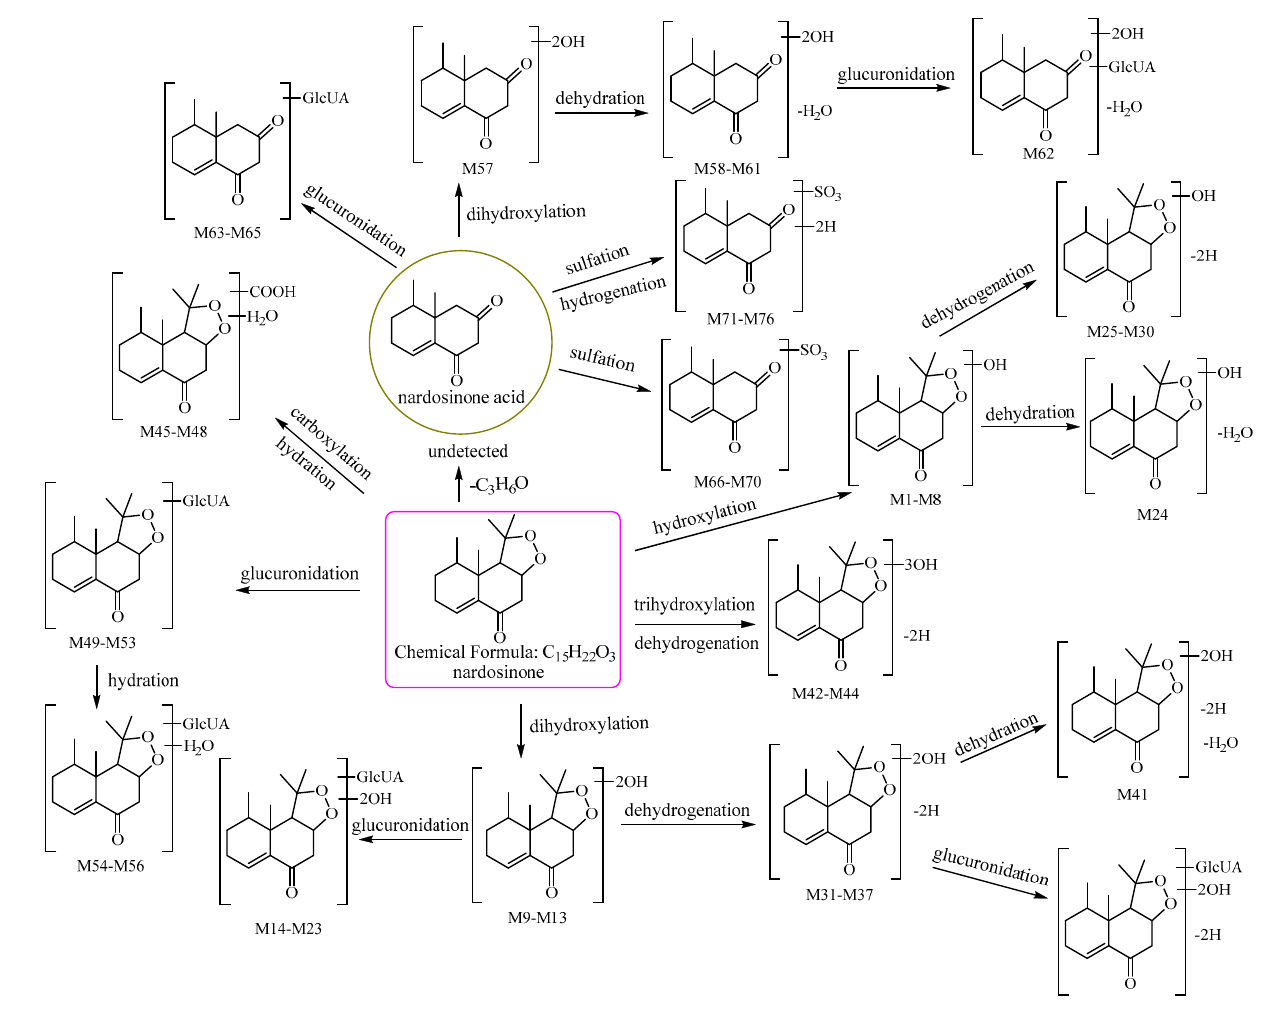
Figure 1. The 76 new metabolites and proposed metabolic pathway of nardosinone in mice. The pink rim and olive circle represent nardosinone and nardosinone acid, respectively.